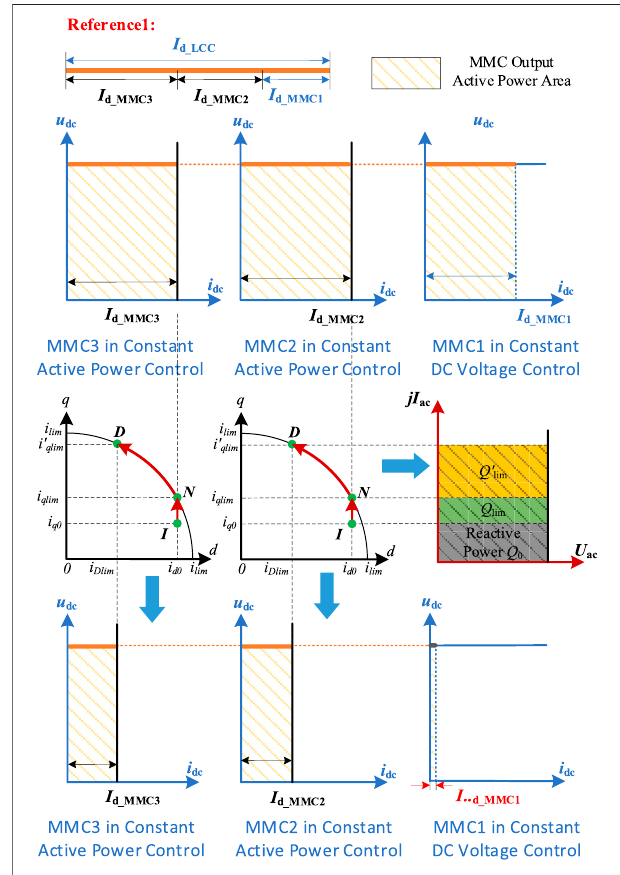
FIGURE 10 | The mechanism of the coordinated strategy based on dynamic limiters and